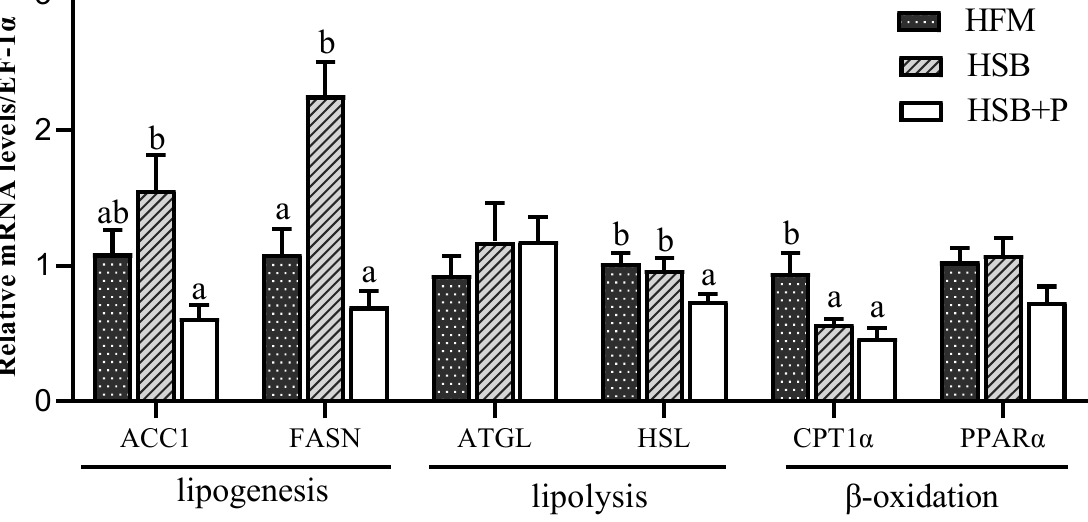
Figure 1. Relative mRNA levels of lipid metabolism genes in liver tissue of largemouth bass. The lipogenesis genes ACC1 and FASN, lipolysis gene HSL, and β -oxidation gene CPT1 α were down- regulated in the HSB+P group (Mean ± SEM, n = 8). ab Values with no or the same superscript letter mean no significant differences ( p > 0.05), while different superscript letters indicate significant dif- ferences ( p < 0.05).